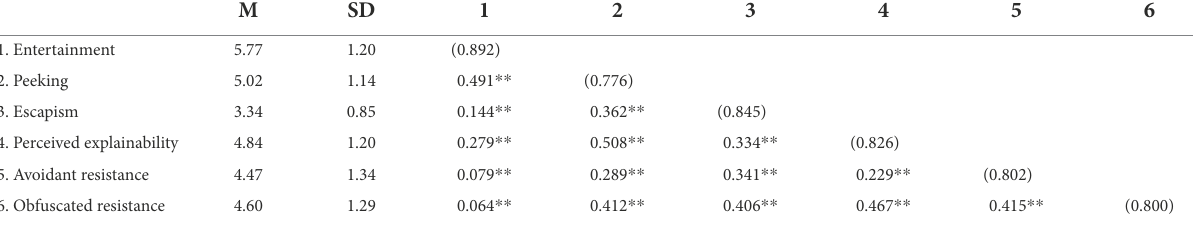
TABLE 4 Descriptive statistics, alpha coefficients, and correlations ( N = 2,000).